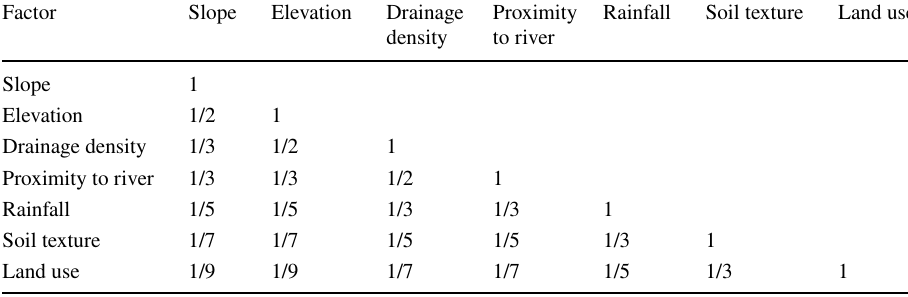
Table 2 Pairwise comparison